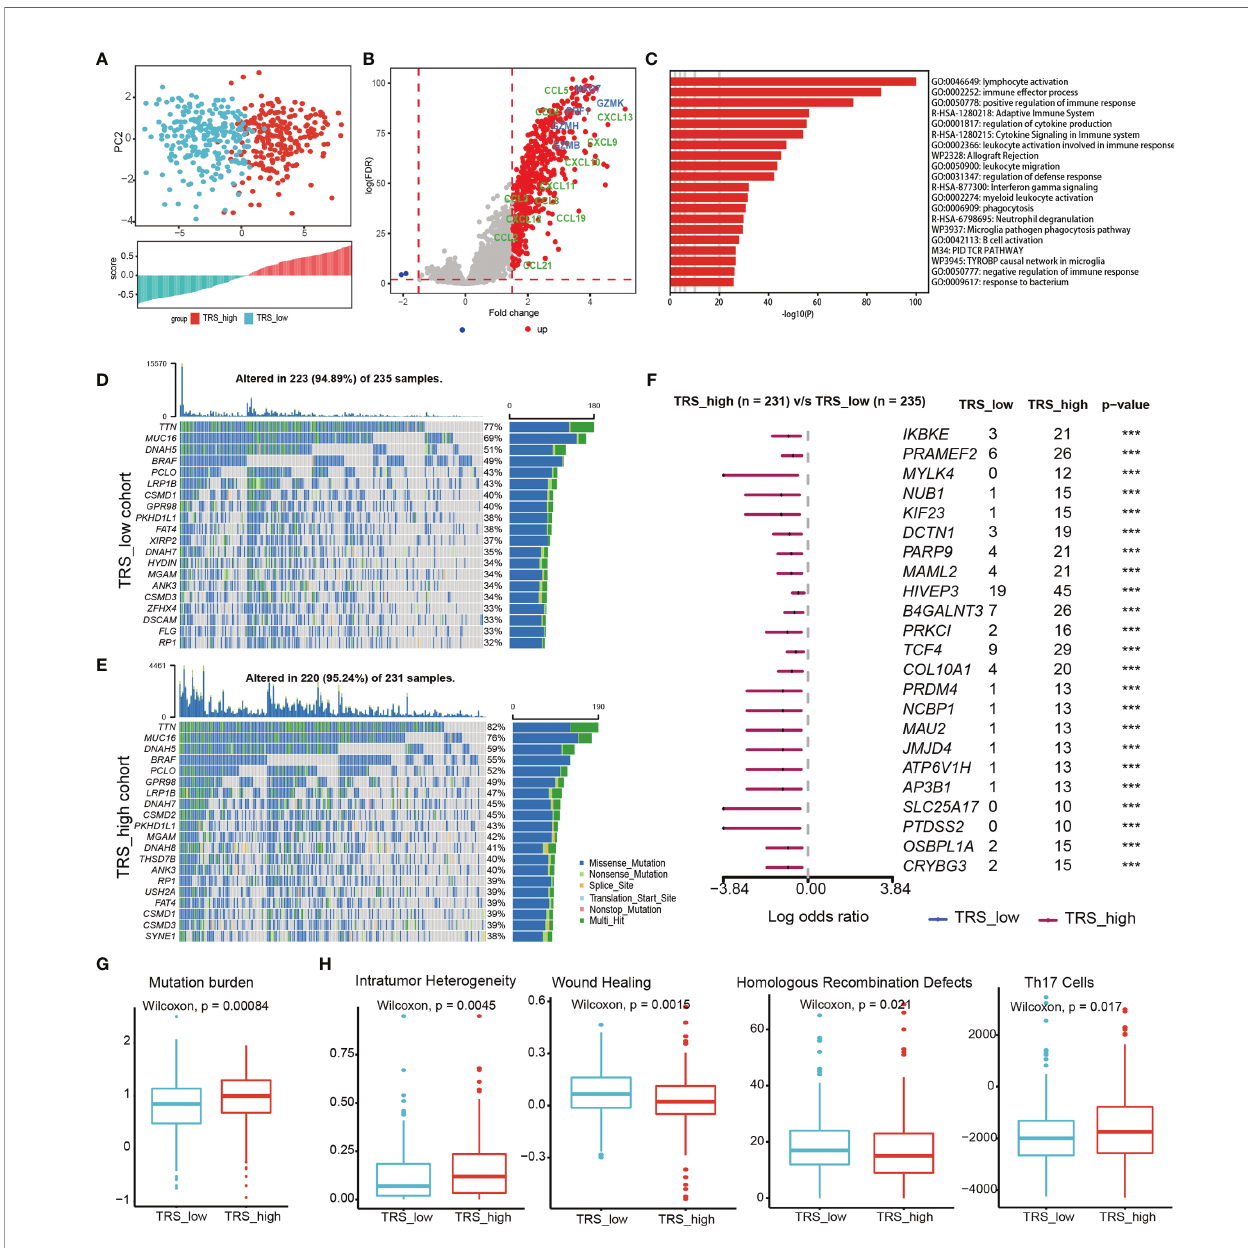
FIGURE 4 | Comprehensive characterization of enriched pathways and genomic aberrations related to tumor reactivity. (A) (Up panel) Principle component analysis with the expression levels of TRS in SKCM. Barplot showing the TRS scores of SKCM patients. (B) Volcano plot showing differentially expressed genes between the TRS_high and TRS_low groups in TCGA cohort. Effect molecules were colored by blue, and chemokine were colored by green. (C) Barplots showing functional gene sets enriched in the signi fi cantly upregulated genes. (D, E) Top 20 most frequently mutated genes were illustrated in the TRS_low (D) and TRS_high (E) group. (F) Signi fi cantly differentially mutated genes between the two groups were displayed. Genes with p-value < 0.001 were considered as signi fi cant. (G) Boxplots showing differences of log transformed tumor mutation burden (TMB) between the TRS_high and TRS_low groups. (H) Boxplots showing differences of intratumor heterogeneity, Wound Healing, Homologous Recombination Defects, and Th17 Cells score between the TRS_high and TRS_low groups. *** denoted p <